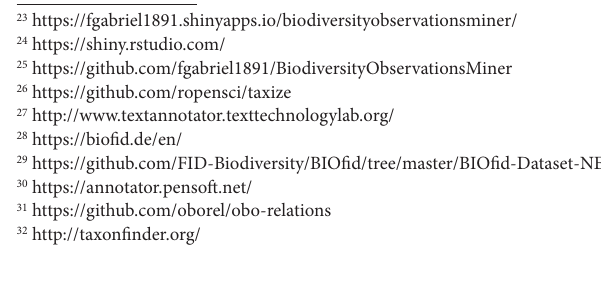
( Figure S1 ). WoRMS Aphia IDs (Vandepitte et al., 2015; Martín Míguez et al., 2019) are widely used and included in